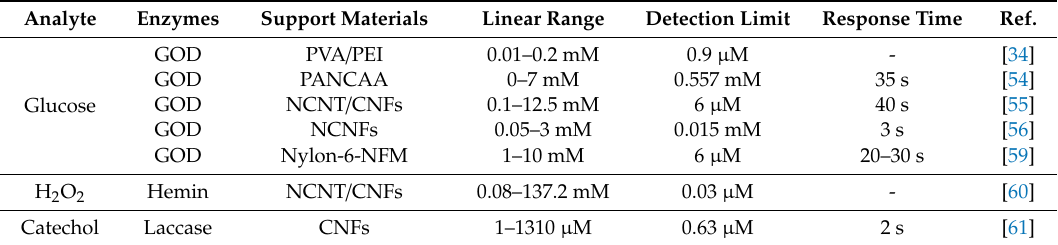
Table 2. The performance of various enzyme electrochemical sensors based on electrospinning.